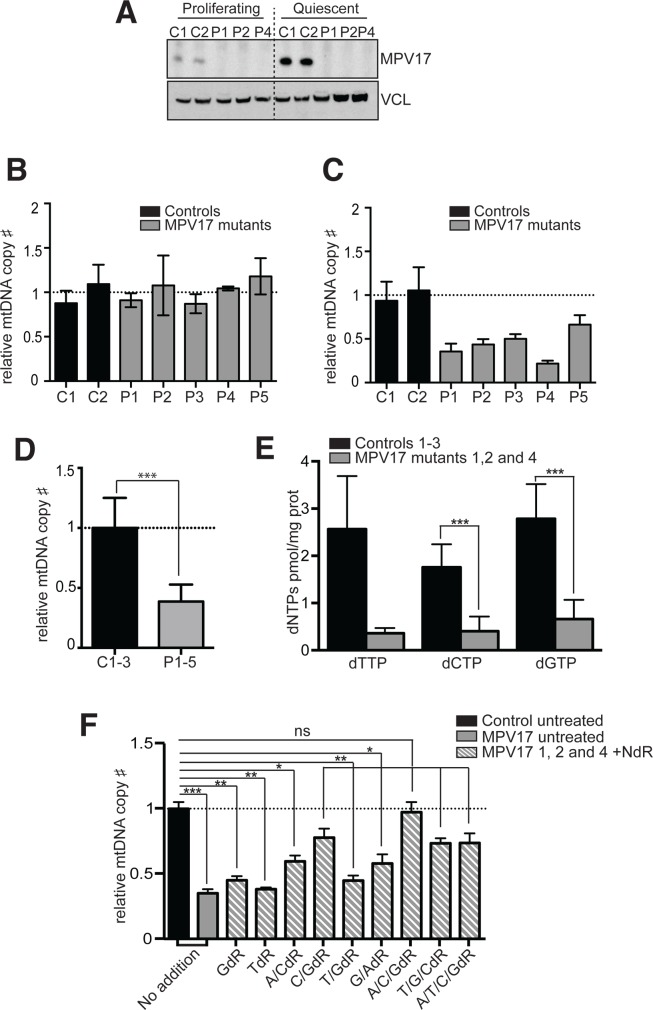
MPV17 is upregulated in non-dividing cells and quiescence induces mtDNA depletion in MPV17-deficient human fibroblasts, unless supplemented with deoxynucleosides.(A) Steady state levels of MPV17 protein in proliferating and quiescent control fibroblasts. (B) Relative mtDNA levels in proliferating control (black) and MPV17 mutant fibroblasts (gray). (C) MtDNA quantification in quiescent fibroblasts. The mtDNA amount is expressed relative to the mean of the controls. (D) mtDNA copy number of quiescent control and MPV17-mutant fibroblasts. Data are expressed as mean ± SEM of n = 8. (Student’s t test: ***P<0.001). (E) Mitochondrial dNTP levels in quiescent control and MPV17-mutant fibroblasts. dATP levels were disregarded owing to the low values obtained for the controls. dCTP and dGTP were measured in 3 independent experiments in 3 patients and 3 control cell lines. *** P<0.001—Mann-Whitney test. (F) Relative mtDNA copy number in quiescent fibroblasts supplemented with deoxynucleosides. Quiescent fibroblasts were cultured for 14 days in the absence or presence of 50 μM or 100 μM deoxyadenosine (AdR), deoxycytosine (CdR), deoxyguanosine (GdR), deoxythymidine (TdR) alone or in the different combinations as indicated. The amount of mtDNA is expressed relative to its amount in proliferating cells (Student’s t test: *P<0.05; **P<0.01; ***P<0.001); C1 and C2, control fibroblasts; P1-P5, fibroblasts derived from patients with pathological mutations in MPV17 (S2 Table).